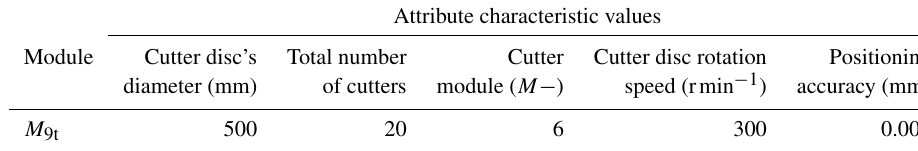
Table 2. Attribute characteristic values of target module.